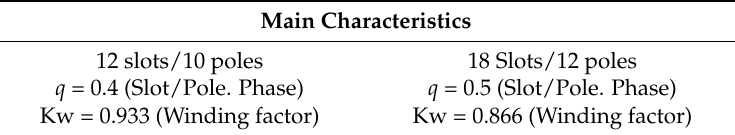
Figure 15. Amplitude of MMF in the air-gap as a function of harmonic rank. Even if the 12-pole/18-slot configuration has fewer harmonics, amplitude of its main harmonic is lower than the amplitude of the main harmonic of the 10-pole/12-slot configuration. Table 2. Comparison between the winding factors of two machines having different number of slots per pole per phase.